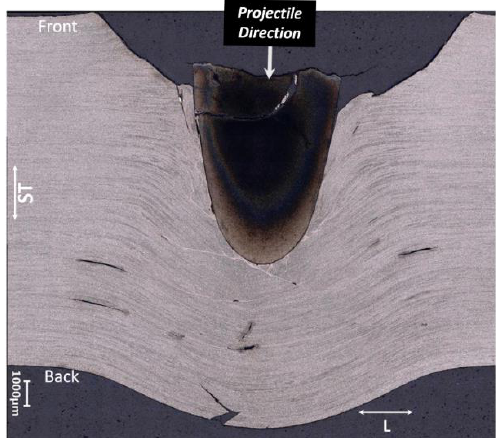
Figure 14. Cross-sectional view of a partial penetration of 13.6 mm (0.536 inches) Ti108 plate by a .30 AP M2 projectile at 679 m s − 1 (2227 ft s − 1 ). This impact velocity was slightly below the V50 of 687 m s − 1 (2254 ft sec − 1 ) [49].